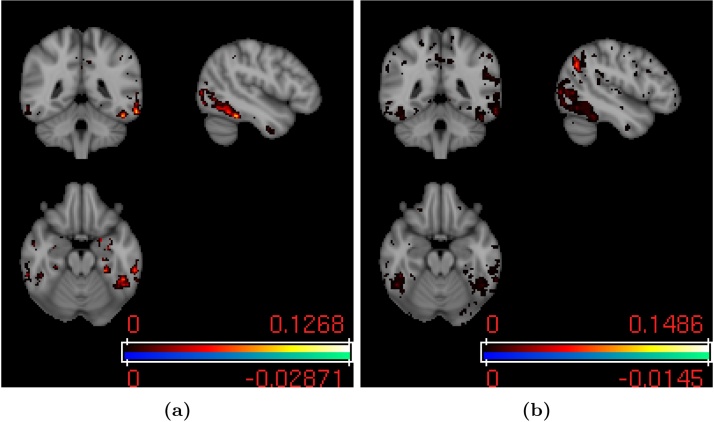
(a) Mean of second image weight vectors using SPLS with projection deflation; (b) Mean of second image weight vectors using SPLS with PLS deflation.